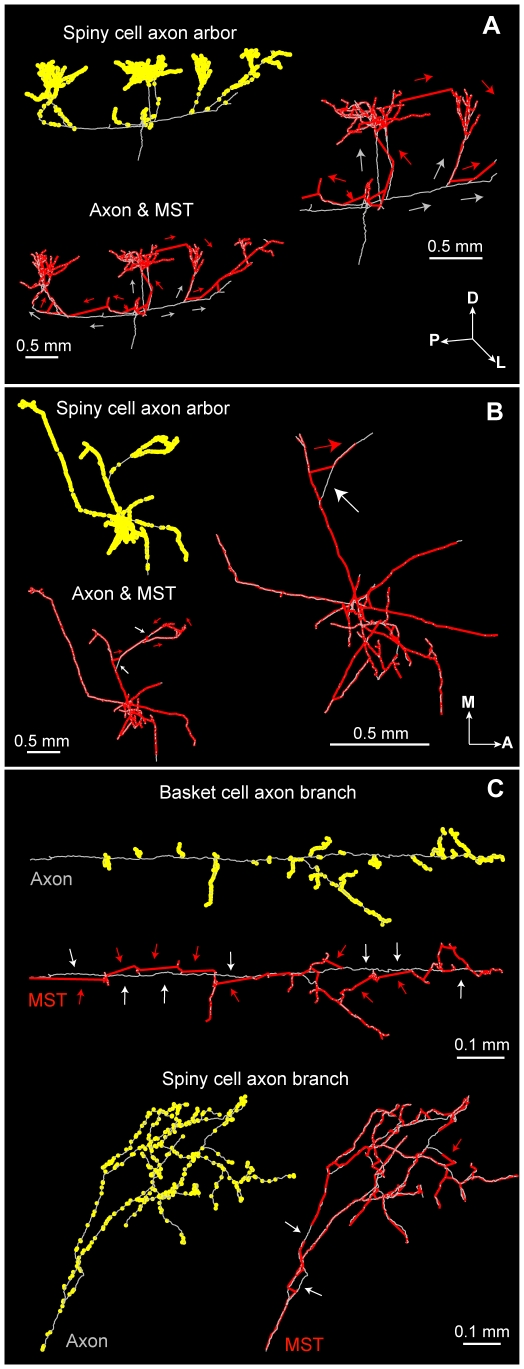
Examples of wiring ‘shortcuts’ by wire-minimization algorithms.(A) Low economy spiny axon arbor (left upper) wiring was significantly shortened by MST (left lower) shortcuts linking bouton-rich terminal patches while avoiding bouton-free primary and secondary axon collaterals. Magnified central region (right) shows numerous wiring differences in the flow direction from soma to tips between overlaid axon (grey arrows) and MST (red arrows) arbors. (B) High economy spiny cell axon arbor (left upper) wiring was only slightly shortened because MST (left lower) could find fewer shortcuts because of the more uniform bouton distribution over the sparsely branched axon arbor. Magnified central region axon and MST overlay (right) illustrates few differences in wiring pattern flow between these arbors. (C) Cell type-specific differences in wiring shortcuts: for a typical basket cell axons wiring shortcuts zig-zag between boutons ‘strings’ on terminal branches but avoid the main bouton-free axon collateral (upper), while for a typical spiny cell branch boutons are found on all orders of branching permitting very few shortcuts (lower). (Key: axon  =  grey lines, graph  =  red lines, boutons  =  yellow dots; anatomical axes: A, anterior; D, dorsal; L, lateral; M, medial; P, posterior).